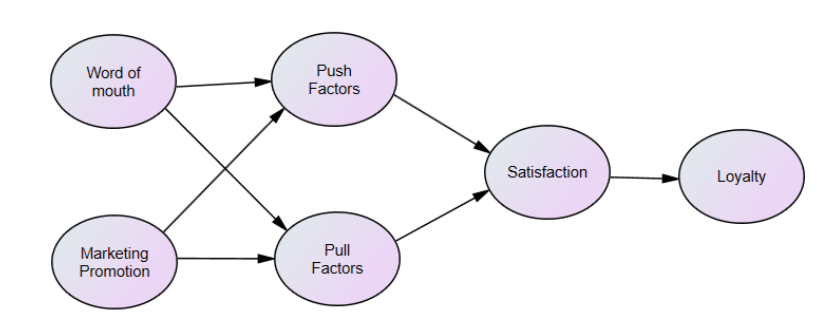
Figure 1 : Theoretical Model on